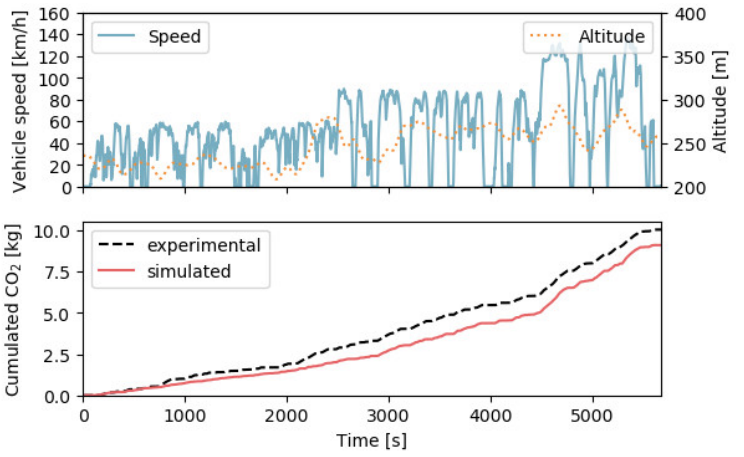
Figure 12. Vehicle 4: RDE trip characteristics ( top ) and CO 2 emissions results ( bottom ).